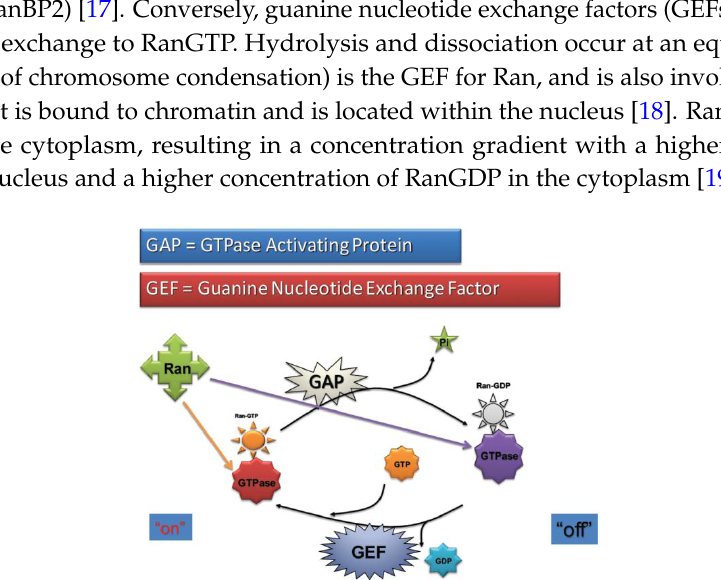
Figure 3. Regulation of RanGTP/GDP Switching. This diagram shows the cycling of Ran between the active GTP state and inactive GDP state. This cycling is regulated by GTPase activating proteins (GAPs) and guanine nucleotide exchange factors (GEFs). Cancers 2016 , 8 , 35